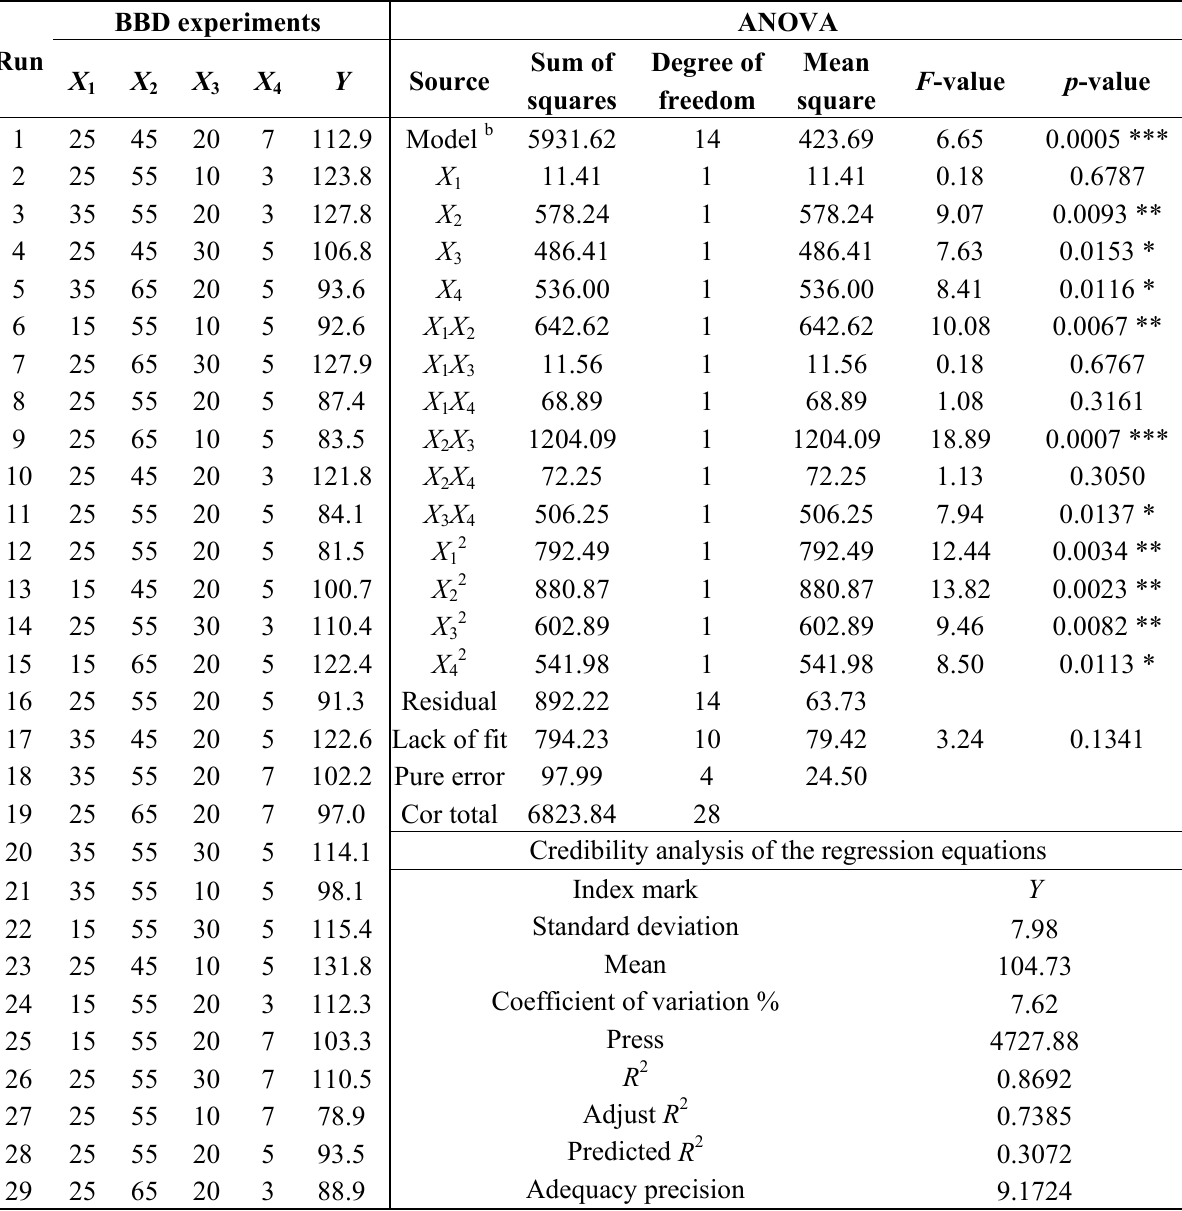
Table 1. Experimental design matrix to screen for variables that determine the mean particle size (MPS) of GTW and ANOVA results a